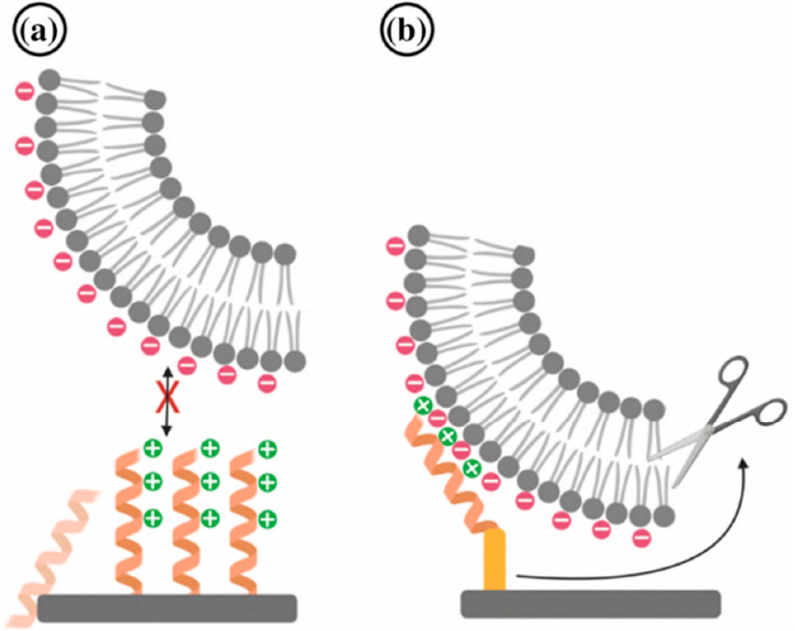
Figure 11. ( a ) Rigid or tight immobilization of cationic peptide prevents interaction with pathogen membrane. ( b ) The Linker region (yellow) provides flexibility to the peptides to form a secondary structure and target the anionic membrane when in contact (reprinted with permission from Stillger et al. [118]). When taken as a whole, selecting a surface coating method using AVPs is challeng ‐ ing. A number of factors, including the peptide type, its sequence and structure, the type of surface bond formation, surface topology, and base materials, have a considerable im ‐ pact on choosing the ideal combination for the intended application. Recently, some of these peptides have been used to chemically immobilize medical device surfaces to give them antimicrobial properties [122,123]. On titanium, glass, contact lens, fabric, and